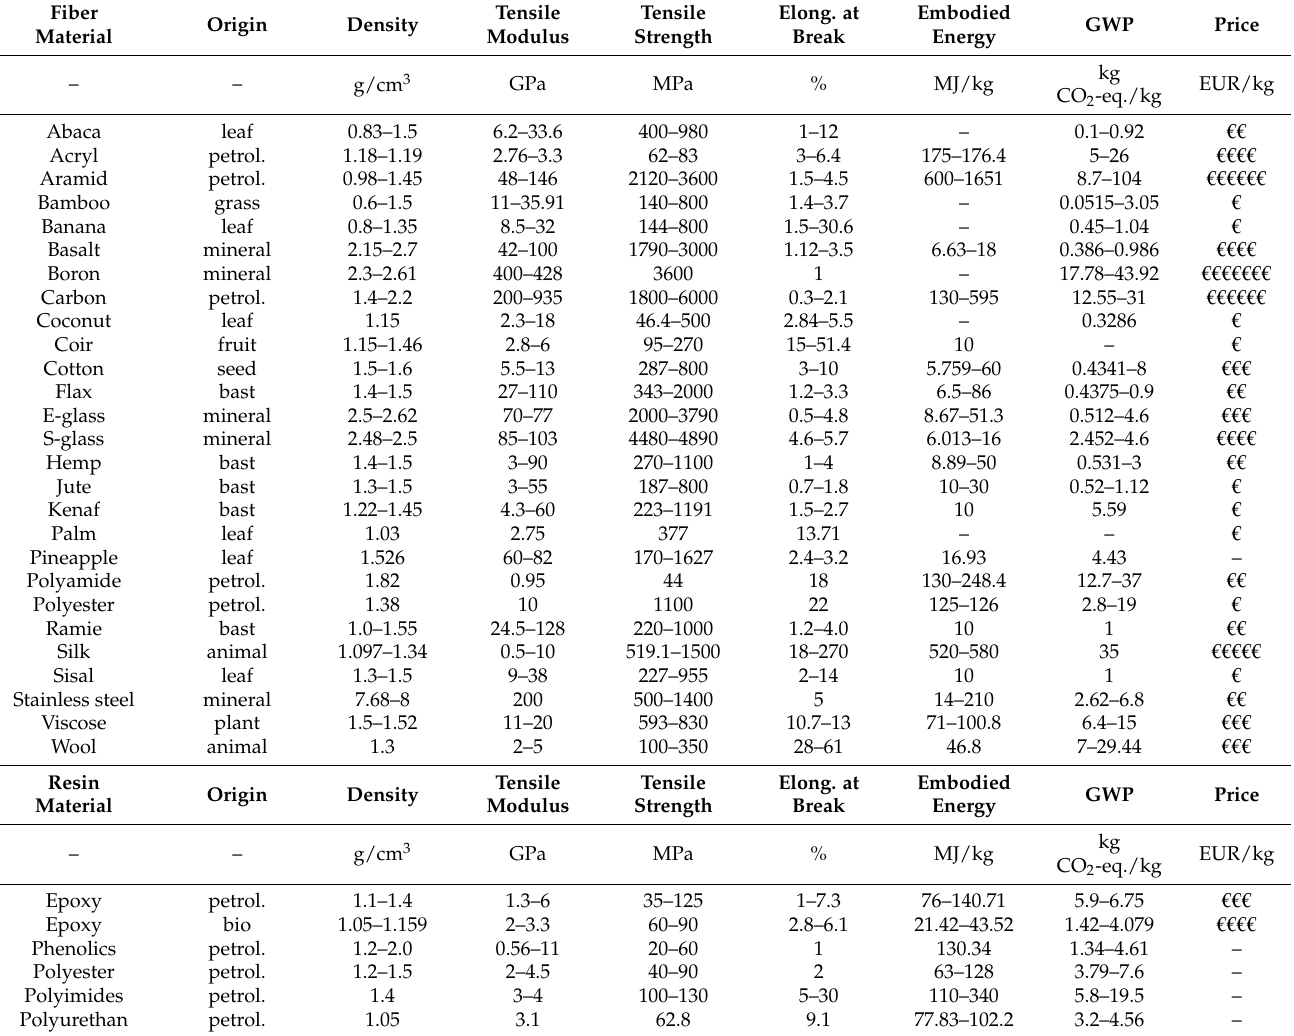
Table 1. Overview of several reinforcement fibers and thermoset matrix systems collected from the literature, complete ranges and references in Table